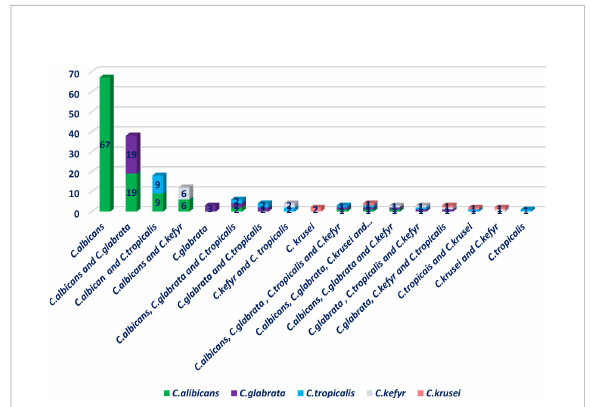
FIGURE 2 Distribution of Candida species causing oral candidiasis based on single or multi- Candida